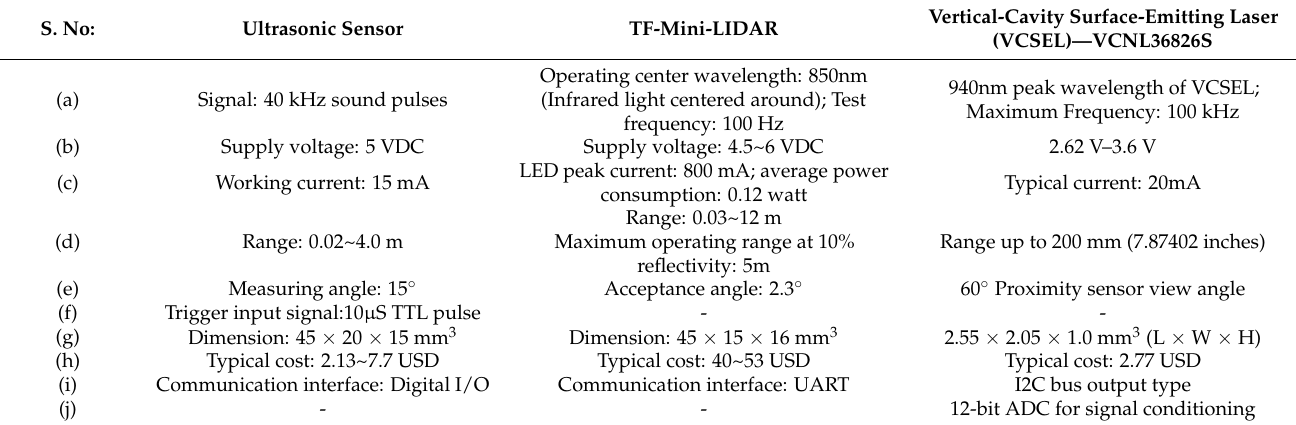
Table 4. Typical ultrasonic, LIDAR, and VCSEL proximity sensors.